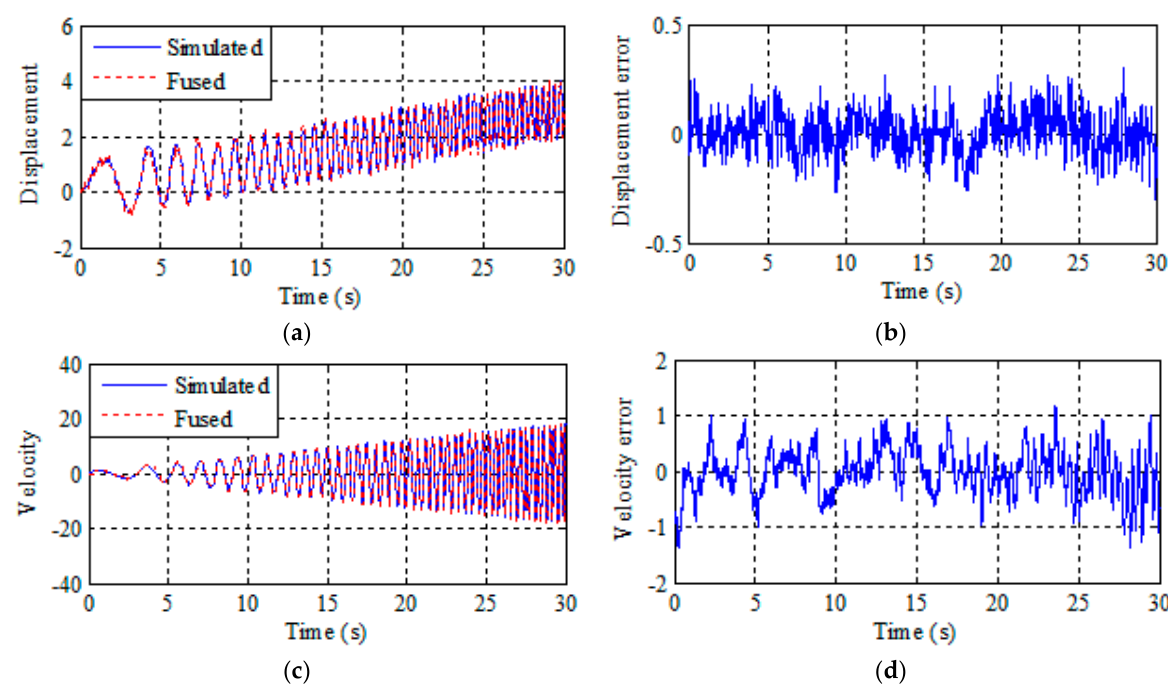
Figure 1. Traditional multi-rate fusion and estimation error of displacement and velocity. ( a ) Displacement traditional multi-rate fusion. ( b ) Displacement error. ( c ) Velocity traditional multi-rate fusion. ( d ) Velocity error.